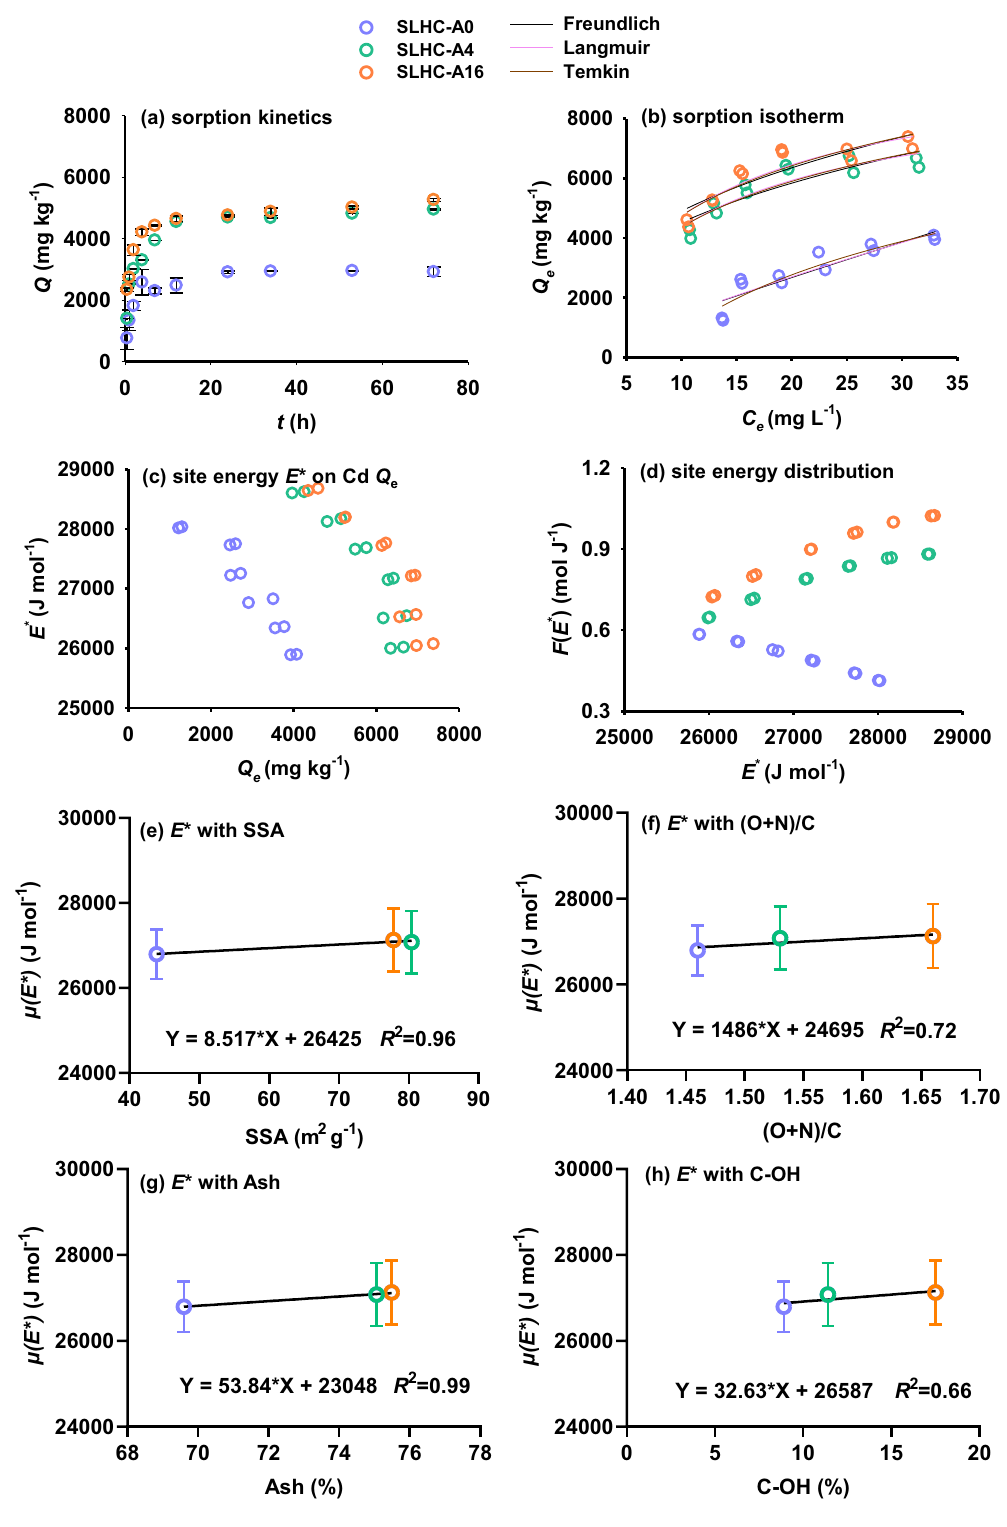
Fig. 3 a Sorption kinetics, b sorption isotherm, c Langmuir model based-site energy on Cd solid-phase sorption, d Langmuir model based-site energy distribution of Cd to fresh and aged sludge-derived hydrochar, and the relationship between average sorption site energy ( E * ) and e SSA, f (O + N)/C, g ash content, and h O abundance (C–